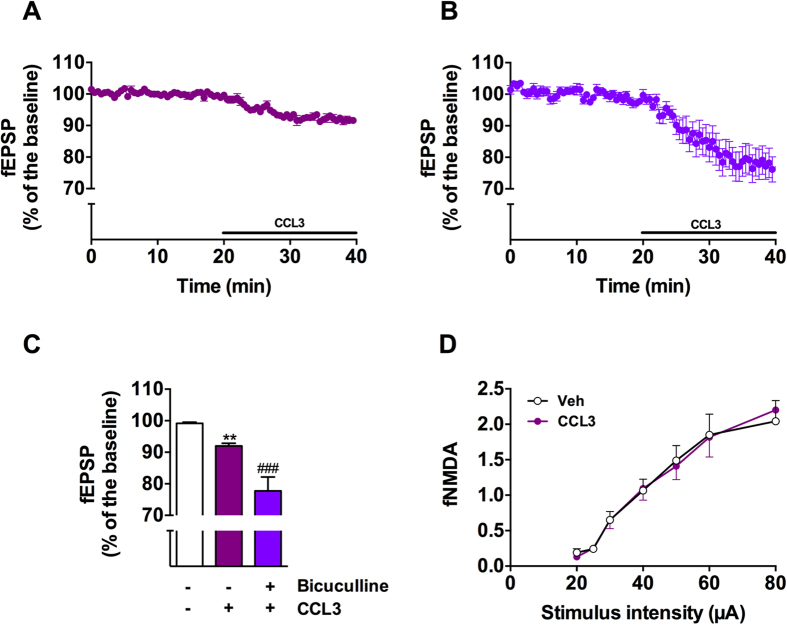
CCL3 decreases basal synaptic transmission without impacting NMDA receptors.(A) Effects of CCL3 (50 ng/mL) on the fEPSPs amplitude (n = 12). (B) Effect of CCL3 on the fEPSPs amplitude in the presence of bicuculline (10 μM; n = 11). Note that in our experiments, bicuculline (10 μM) caused a fEPSP increase reaching 10.0 ± 1.5% of the baseline (n = 4). To compare the effect of CCL3 on the basal synaptic transmission with or without bicuculline, an I/V curve was realized before baseline recording to adjust the intensity of the stimulus of each experiment to elicit a fEPSP of 35% of the maximum. This intensity was kept constant throughout the CCL3 application. Each point represents mean ± SEM normalized to the baseline values preceding the application of CCL3. Horizontal bar represents chemokine application (50 ng/mL, 20 min). (C) Representative histograms of fEPSP variation during the last five minutes of drug application. **p < 0.01 vs. baseline; ###p < 0.001 vs. CCL3 alone, using One-way ANOVA and post-hoc LSD Fisher test. (D) CCL3 (50 ng/mL) does not affect NMDAR-mediated field potential input-output curves.